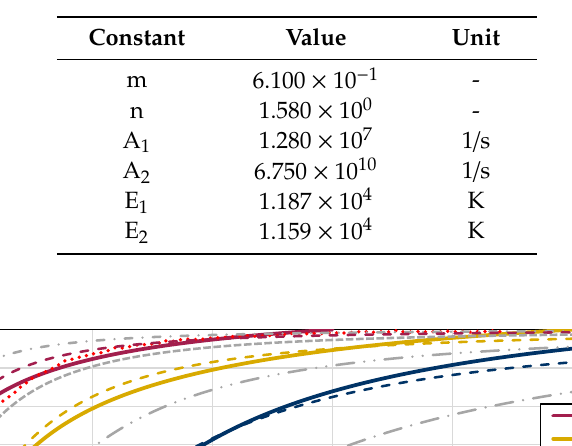
Table 4. Kamal curing model constants.